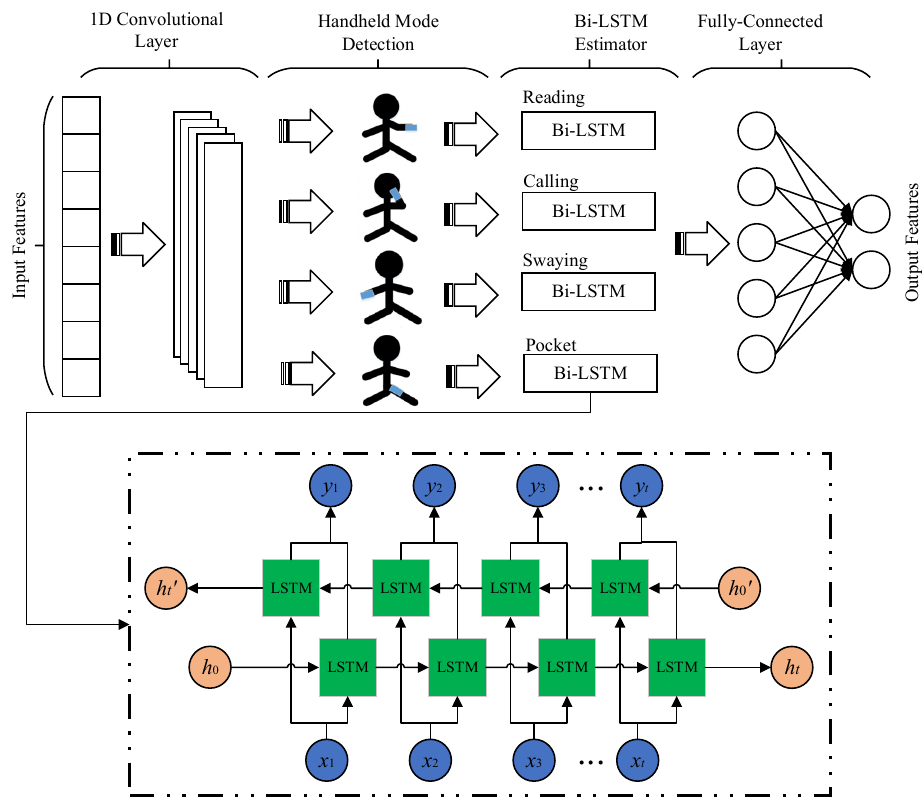
Figure 2. Deep-learning Framework of Speed Estimator.